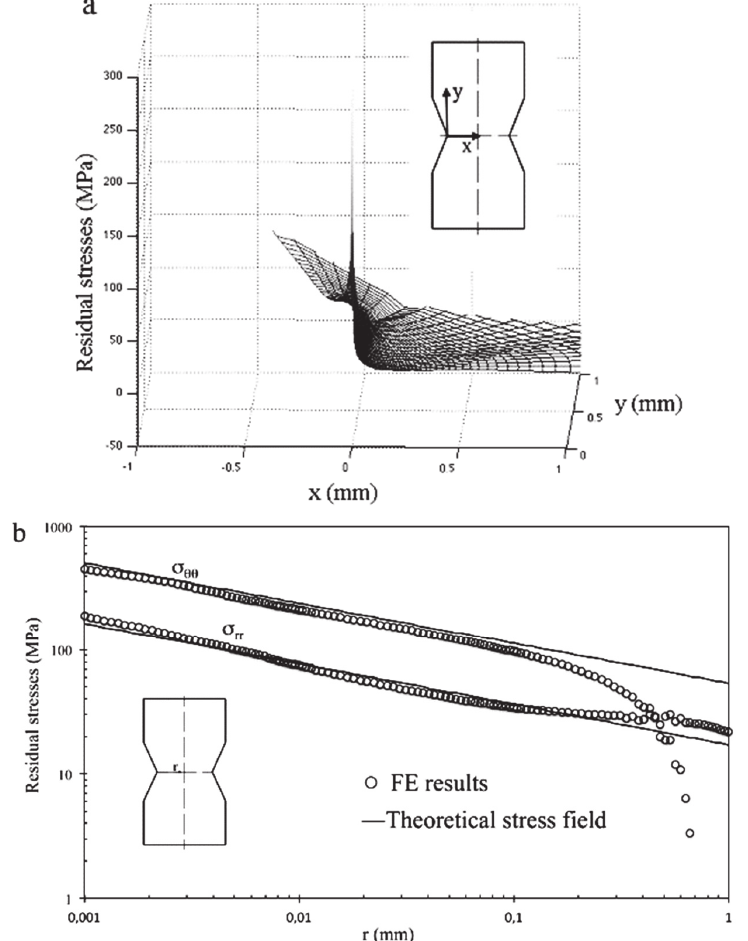
Figure 2: (a) in-plane distribution of residual stresses (radial component, σ r ) near the notch tip; (b) Tensile residual stresses along the bisector of the V-notch (2 β =135°),